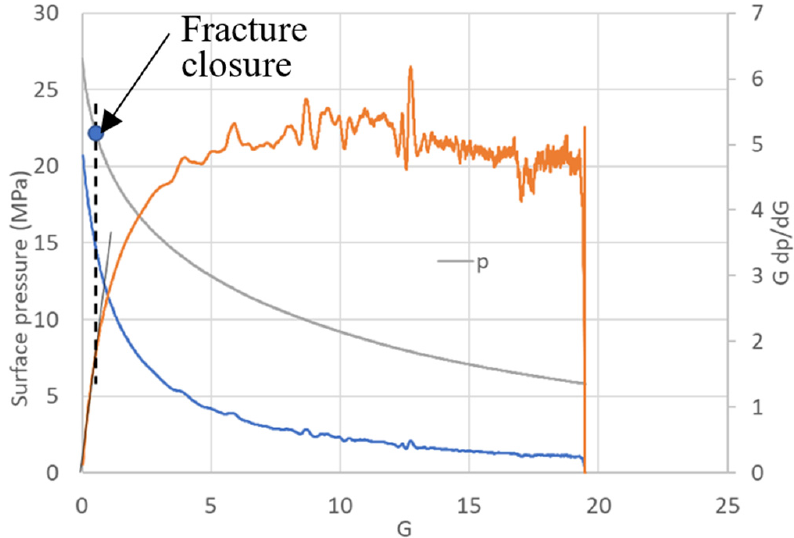
Figure 12. G-function plot of Zone 2 Cycle 8. The surface pressure at closure is 22.1 MPa, using the initial tangent. The calculated bottomhole pressure at closure is 42.8 MPa, and the closure stress gradient is 20.1 MPa/km.